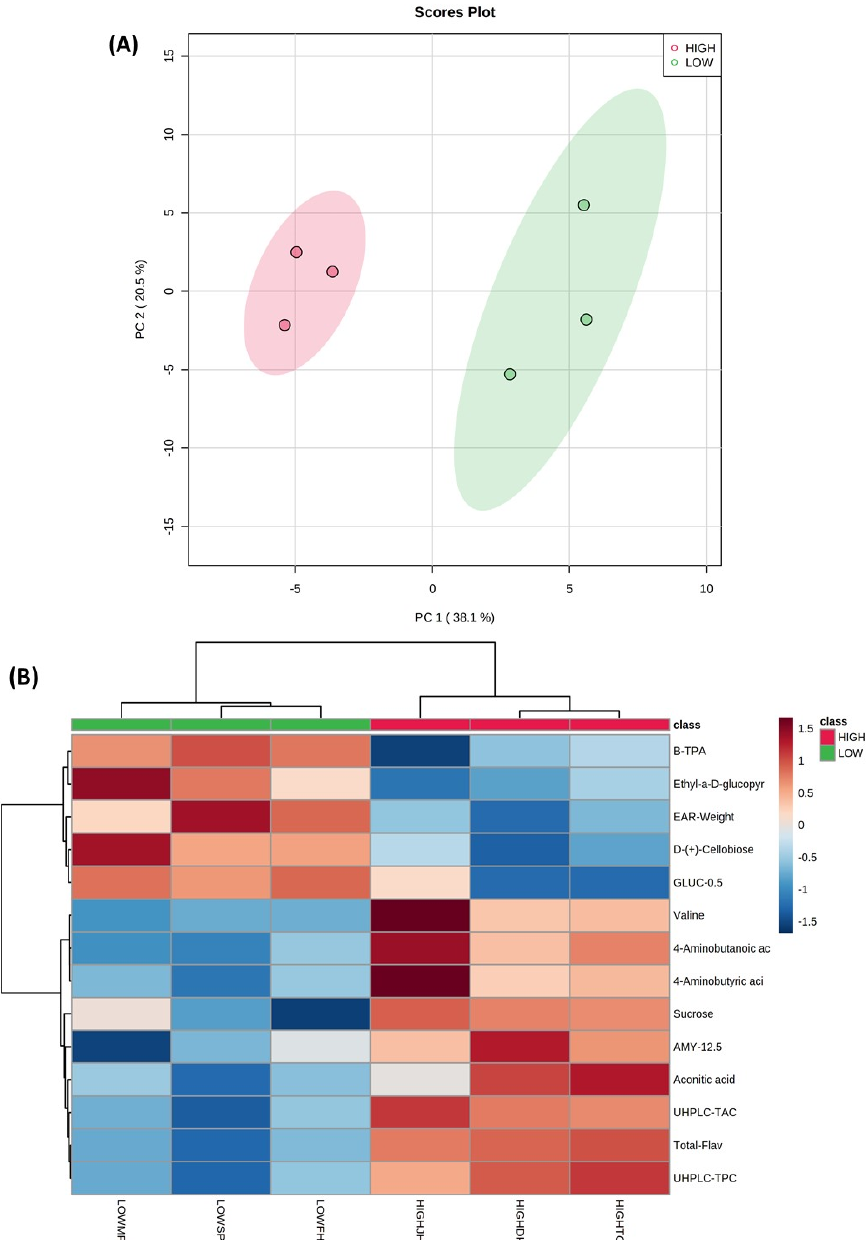
Figure 2. Principal component analysis (PCA) score plot ( A ) and heat map ( B ) considering significant variables from purple corn cob samples grown at two different geographical locations (highland, HIGH and lowland, LOW). Variables in legend: B-TPA, bound total phenolic acid contents; Ethyl-a-D-glucopyr, ethyl-a-D-glucopyranoside; GLUCO 0.5, α -glucosidase inhibition (0.5 mg); AMY-12.5, α -amylase inhibition (12.5 mg); AMY-10, α -amylase inhibition (10 mg); UHPLC-TAC, UHPLC total anthocyanins; Total-flav, total flavonoids; UHPLC- TPC, UHPLC total phenolic compounds. D -cellobiose was detected at lower levels in kernel and cob samples from the highland location when compared with samples from the lowland zone. This disaccharide may have been used as a substrate for the biosynthesis of cellulose, explaining the higher contents of crude fiber found in kernels from purple corn grown at highland conditions. The expression of the sucrose synthase enzyme involved in the biosynthesis of cellulose and starch was increased in leaves of Miscanthus giganteus due to cold stress [57]. In addition, methyl sugars such as the methyl- α - D -ribofuranoside may have been involved in the biosynthesis of cell wall polysaccharides in highland cob samples (Figure S1)